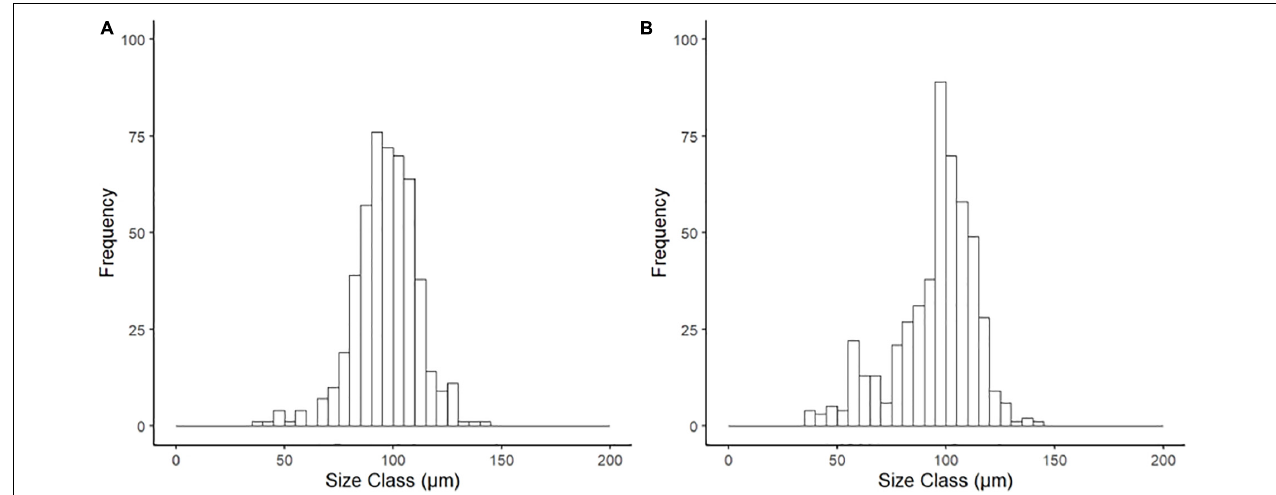
FIGURE 4 | Size frequency of oocytes for Bathyarca glacialis from the Barents Sea following incubation (20 weeks) under (A) ambient and (B) representative future climate conditions. There was no significant difference in distribution between treatments (2-tailed K–S test, D ( 94 ) = 0.122, p = 0.81).